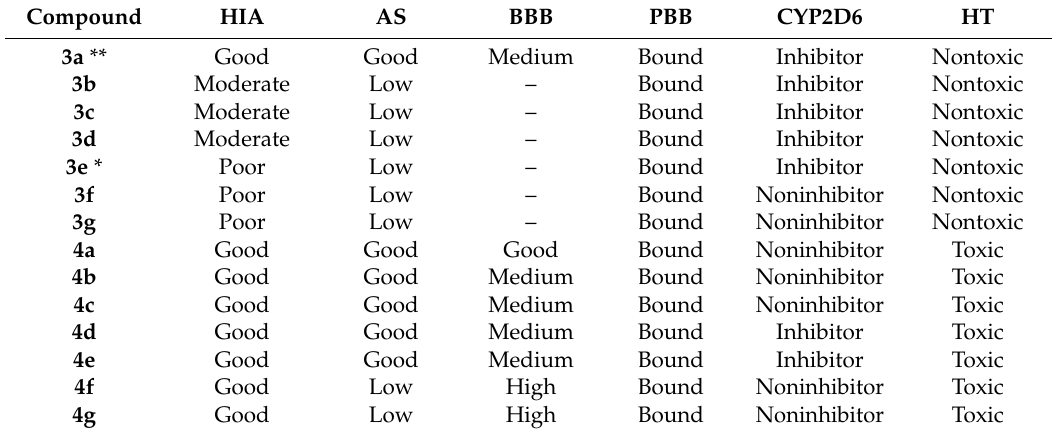
Table 4. Results of absorption, distribution, metabolism, excretion, and toxicity (ADMET) prediction on selected parameters of selected compounds. Compound HIA AS BBB PBB CYP2D6 HT Good Good Medium Bound Inhibitor Nontoxic 3b Moderate Low – Bound Inhibitor Nontoxic 3c Moderate Low – Bound Inhibitor Nontoxic 3d Moderate Low – Bound Inhibitor Nontoxic 3e * Poor Low – Bound Inhibitor Nontoxic 3f Poor Low – Bound Noninhibitor Nontoxic Poor Low – Bound Noninhibitor Nontoxic Good Good Good Bound Noninhibitor Toxic Good Good Medium Bound Noninhibitor Toxic 4c Good Good Medium Bound Noninhibitor Toxic 4d Good Good Medium Bound Inhibitor Toxic Good Good Medium Bound Inhibitor Toxic Good Low High Bound Noninhibitor Toxic 4g Good Low High Bound Noninhibitor